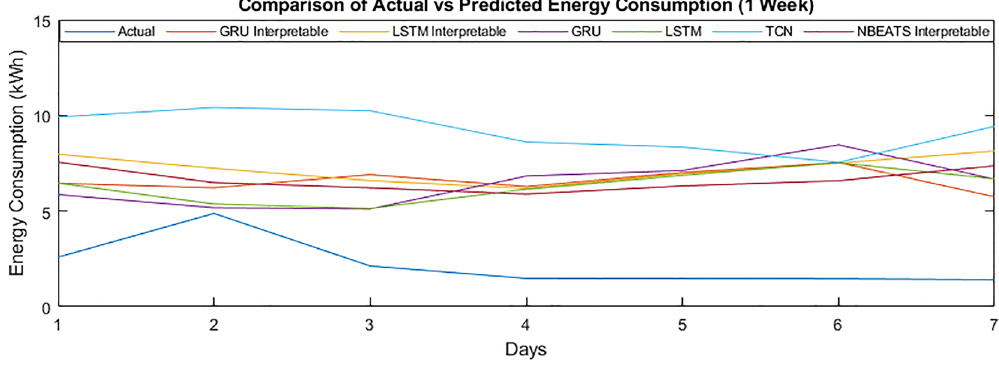
Figure 6. Comparison of actual vs predicted energy consumption (1 week).